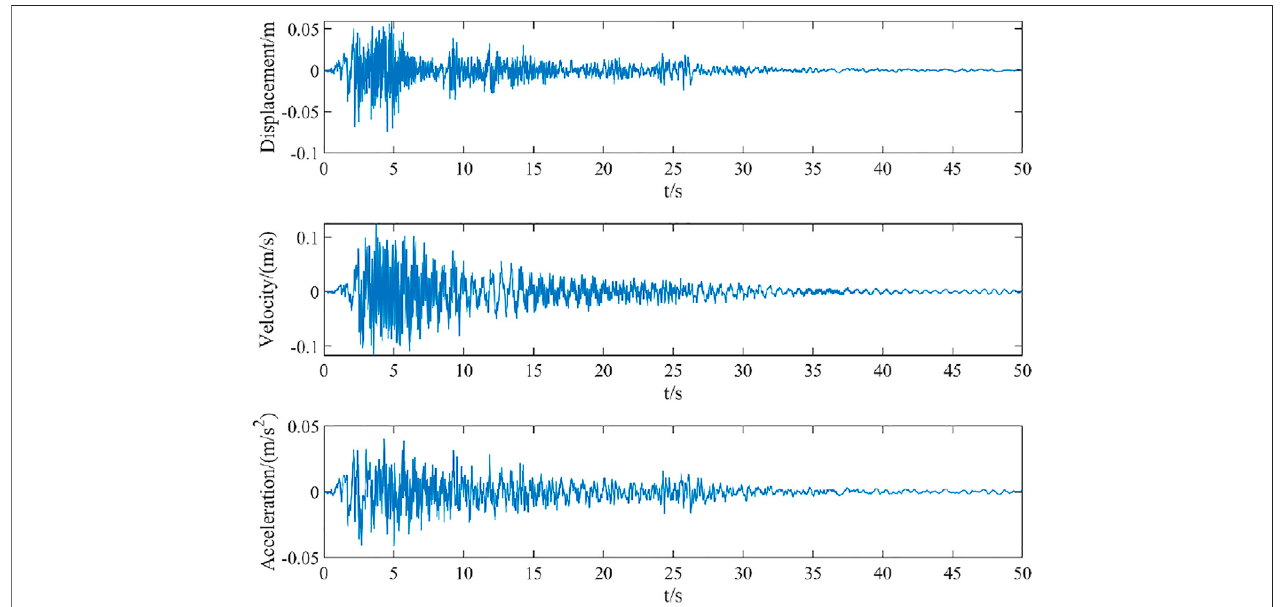
FIGURE 7 | Dynamic response of displacement, velocity, and acceleration output of the original model of simply supported beam.